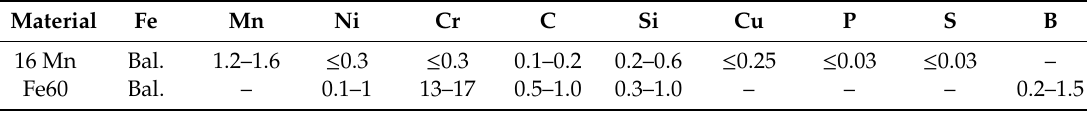
Table 1. The chemical composition of the 16 Mn substrate and Fe60 alloy powder (in wt.%). Material